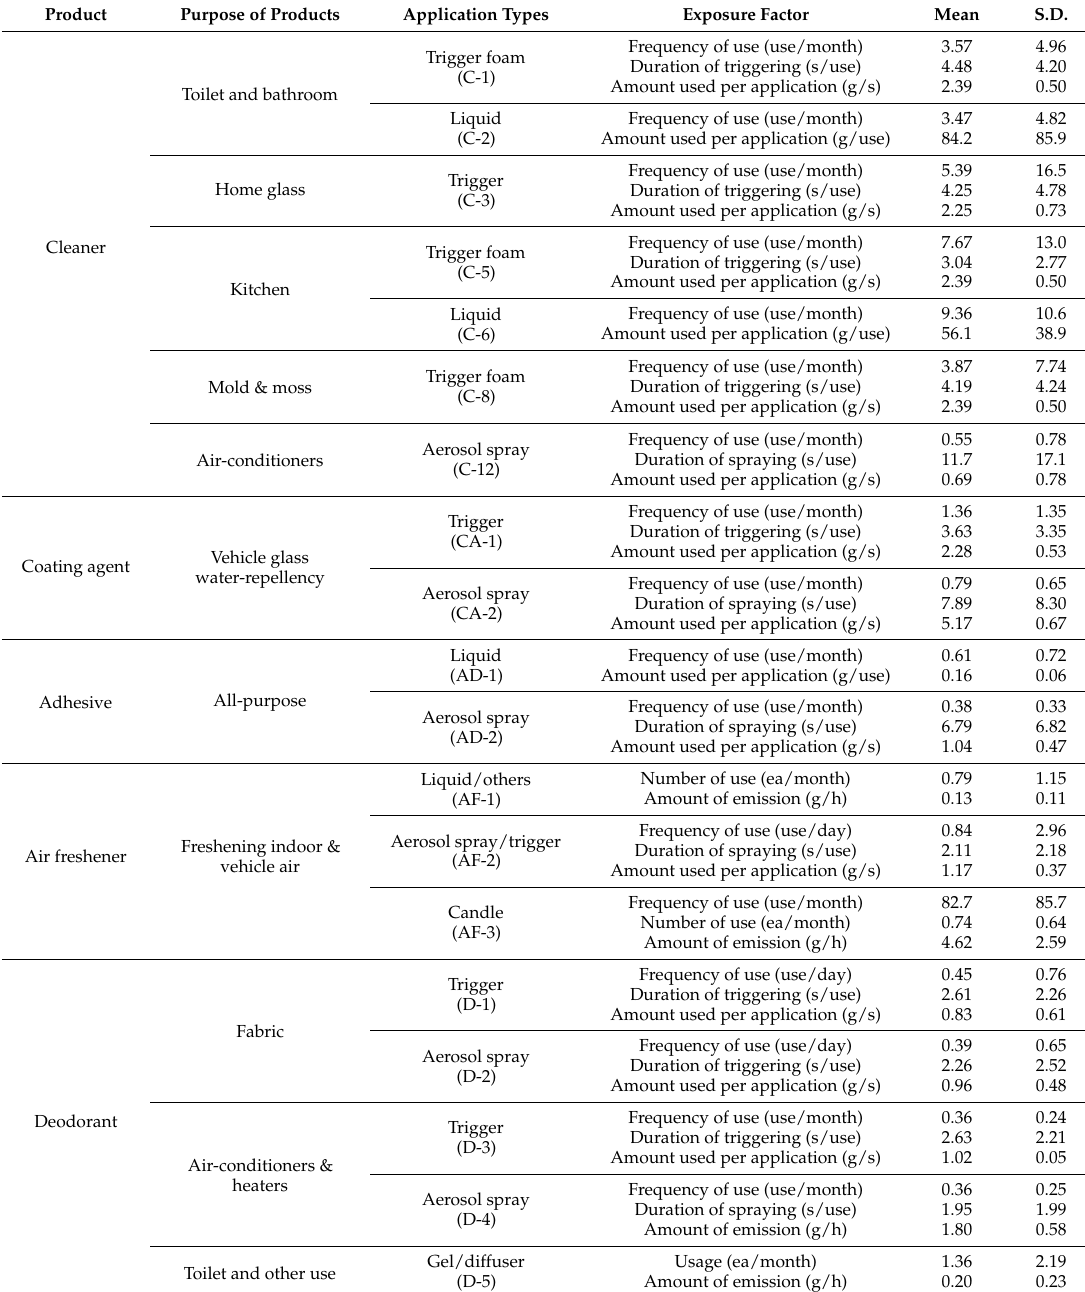
Table A1. Exposure factors of the products